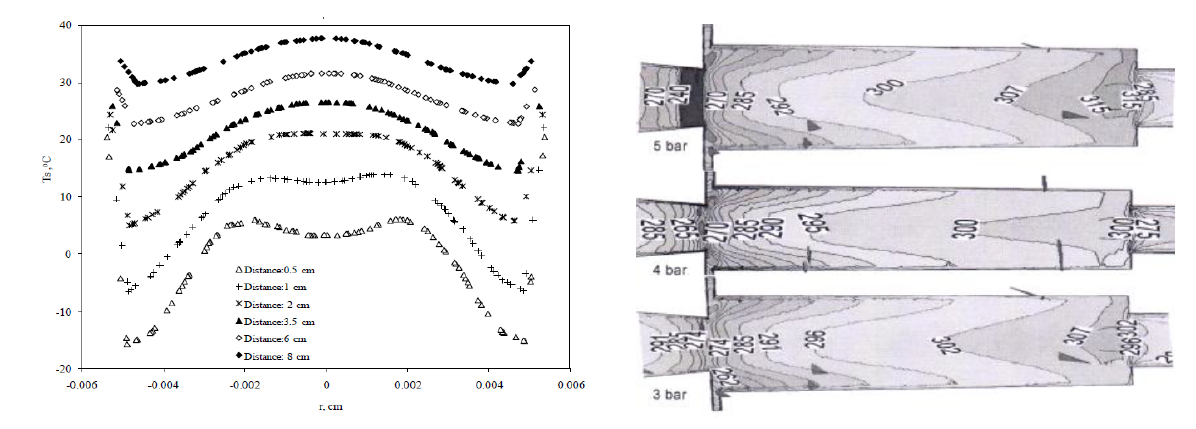
Figure 21. Static temperature contours along axial cross section of vortex tube at different inlet